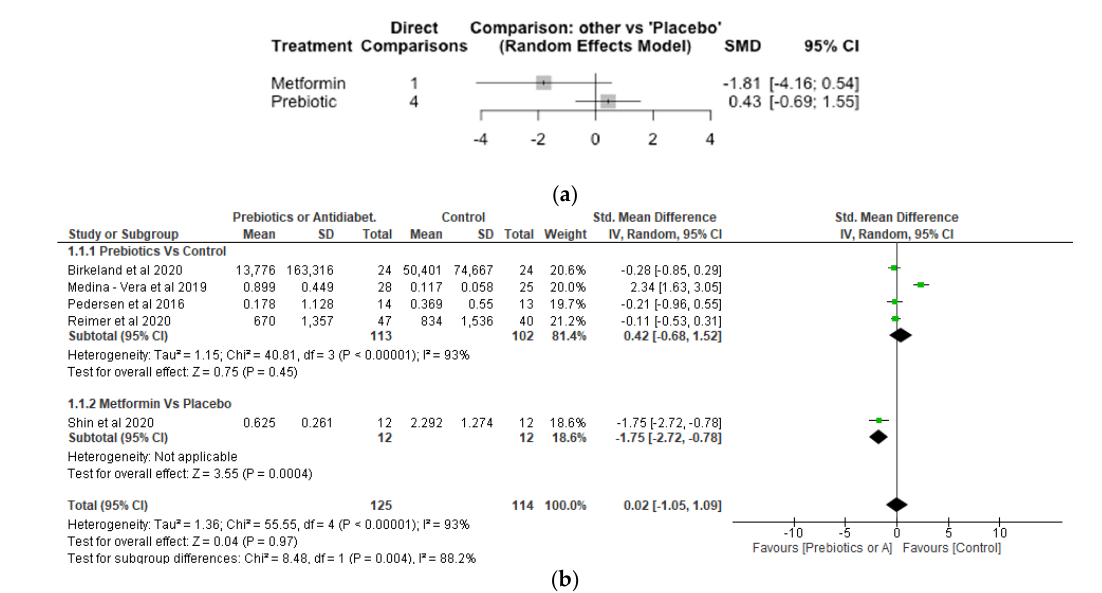
Figure 3. Network Meta-analysis ( a ) and Meta-analysis ( b ) of the effect of treatments versus control on Bifidobacterium [31,32,37,41,42].